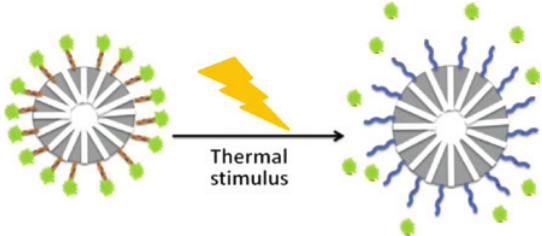
Figure 8: Schematic of thermally responsive MSN: the normal structure of a thermally responsive material is changed under temperature fluctuation. Reused from Reference [45] with the permission of the Royal Society of